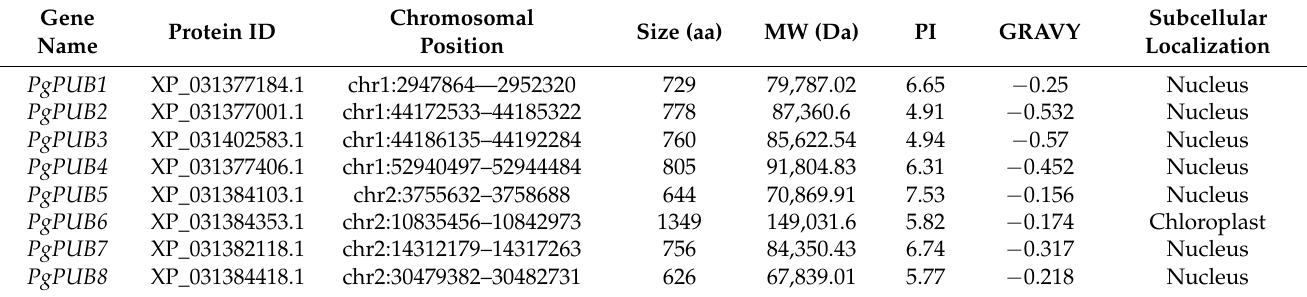
Table 2. Characteristics of the U-box gene family in